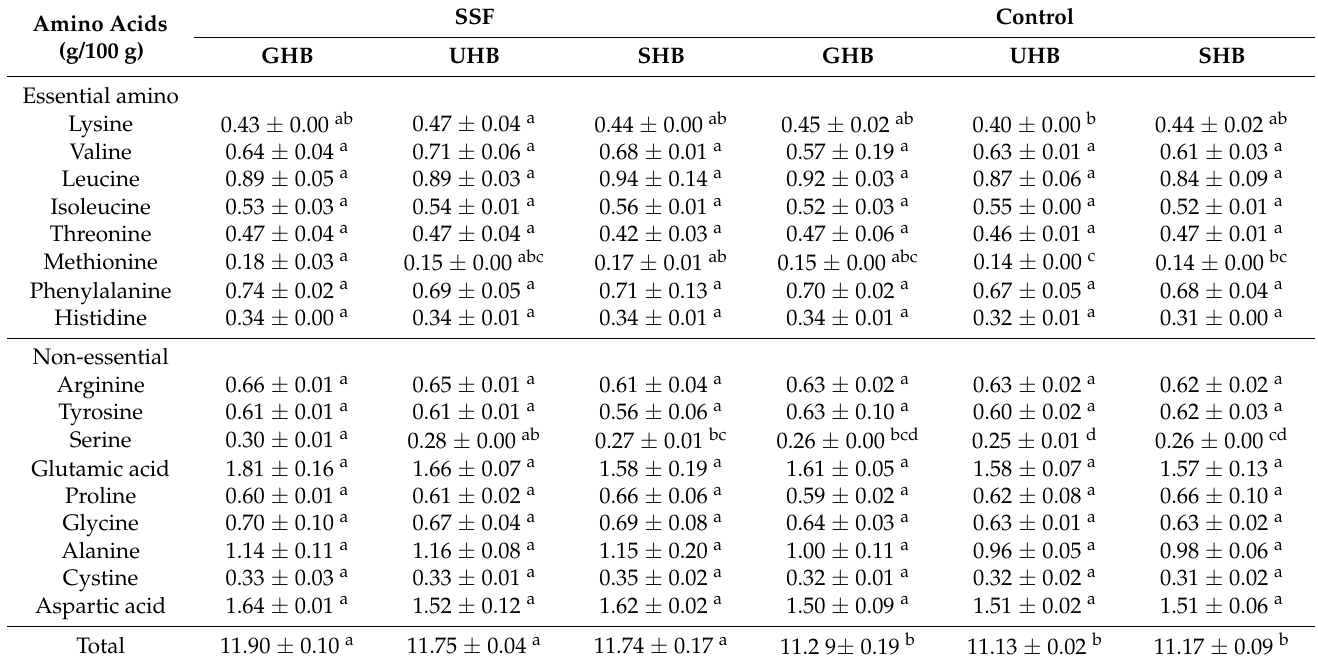
Table 2. Amino acids of the highland barley (the control groups and colonized groups with the mycelia of A. sinodeliciosus var. Chaidam